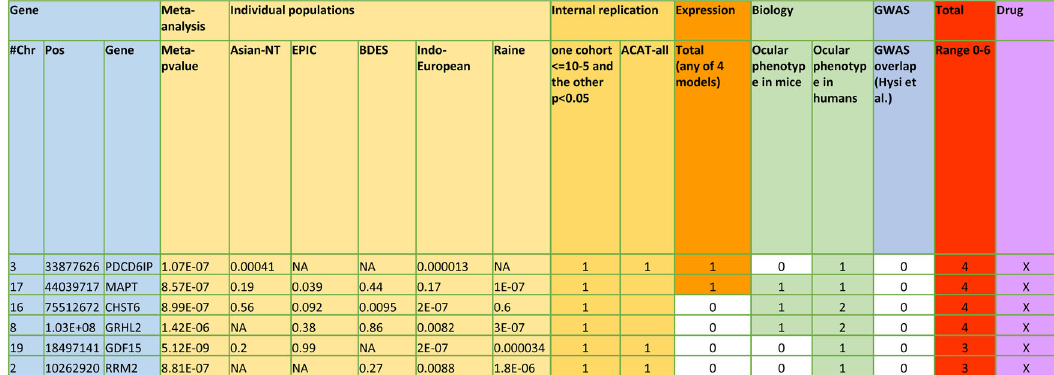
Fig. 7 Prioritization of top genes from all 129 genome-wide signi fi cant genes. The top genes ranked by our prioritization schema. The fi gure contains the chromosome, basepair position, gene name, as well as the meta-analysis p -value and the individual cohort p -values for each gene. It also contains which test the given signi fi cant meta-analysis p -value refers to, and how many times the gene replicated in our internal analyses. Finally, it contains information regarding gene expression, whether the gene has a known ocular phenotype in mice or humans, overlap with the GWAS performed by Hysi et al., and the fi nal overall prioritization score. This fi gure is based on results shown in Supplementary Data